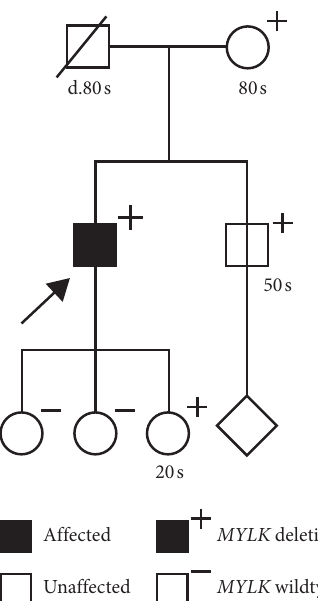
Figure 1: Pedigree of the proband’s family. Known results from family member MYLK . Testing and current clinical status are